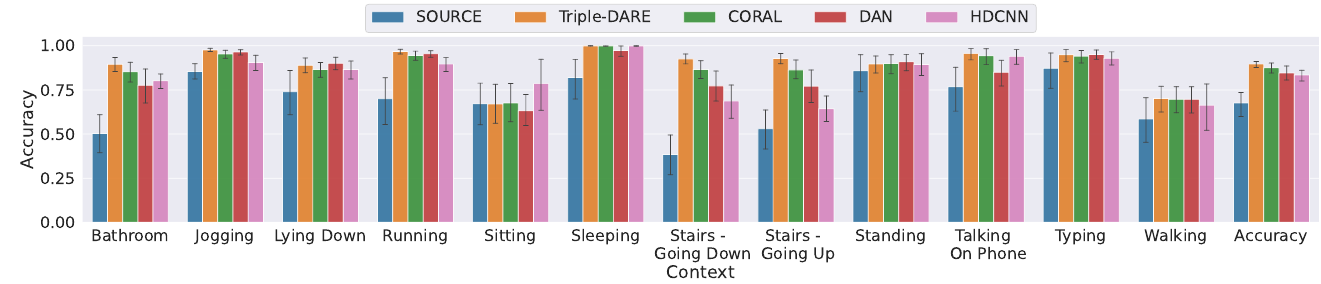
Figure 5. Target prediction scores for each label, averaged across various UDA task